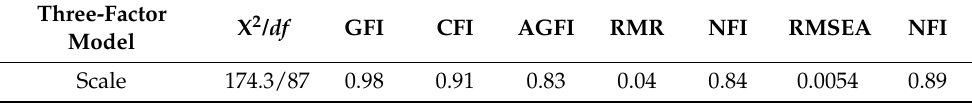
Table 4. Construct validity of the TFI-T. Three-Factor